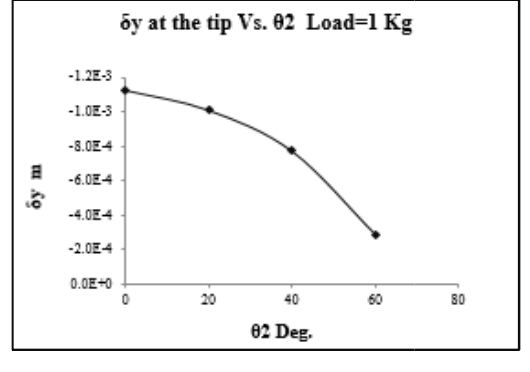
Fig. 12. δ y Vs. θ 2 Deg. Link-2